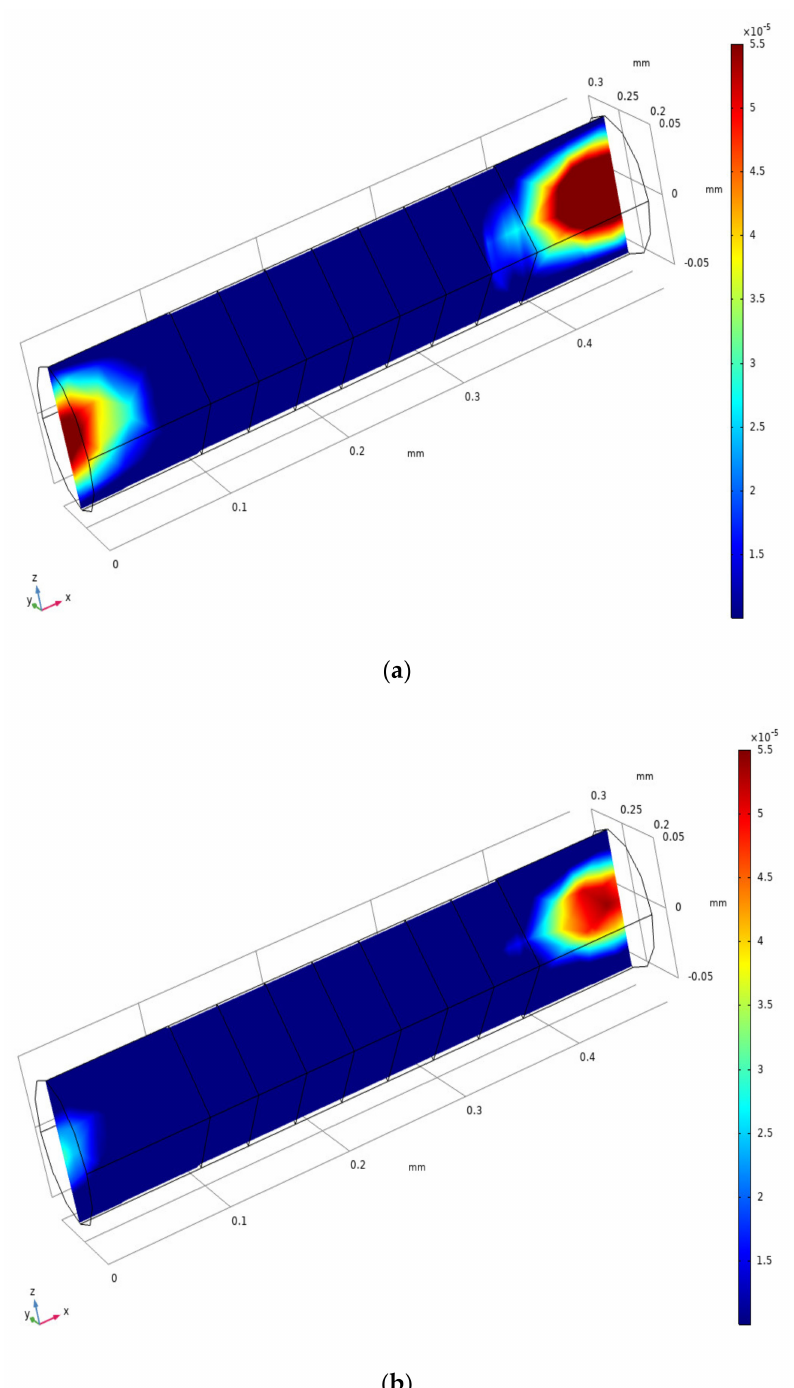
Figure 4. Radial velocity field distribution of the xz plane in the sensing element under ( a ) turbulent- laminar flow model and ( b ) laminar flow